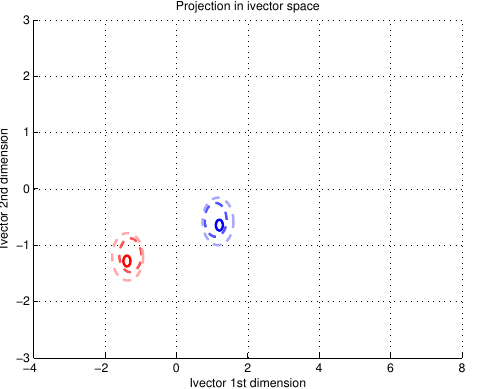
Figure 2. Comparison of posterior distribution of the i-vectors with reference phoneme distribution. Continuous line ellipse represents the original utterance while dashed-lined ellipses illustrate utterances with the limited data.